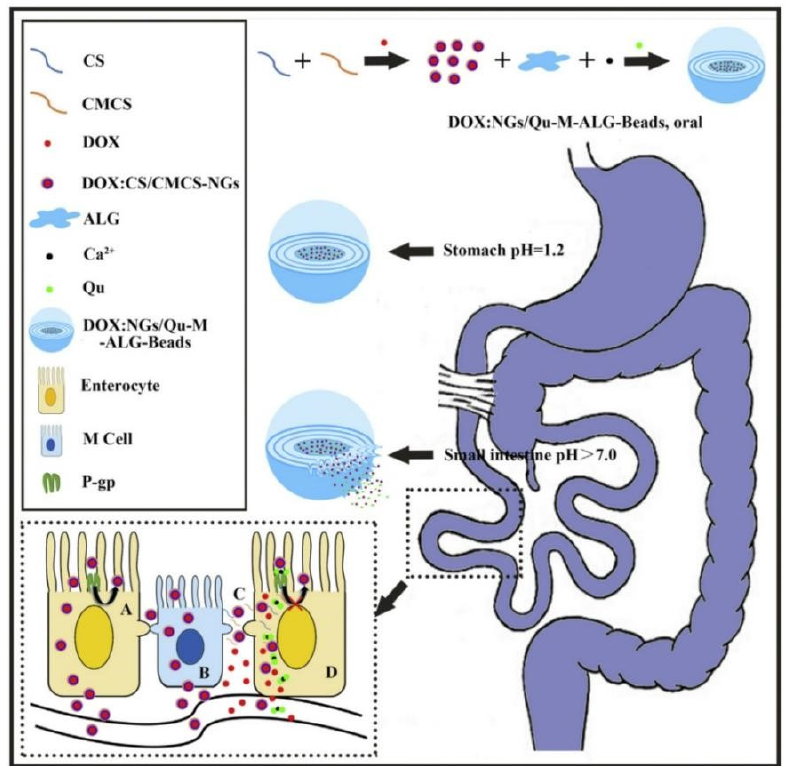
Figure 5. Schematic illustrating the effect of DOX: NGs/Qu-M-ALG-Beads on improving the oral absorption of DOX: (A) transcellular pathway by pinocytosis, (B) transcytosis by M cell, (C) para- absorption of DOX: A: transcellular pathway by pinocytosis, B: transcytosis by M cell, C: paracellular cellular pathway by CS/CMCS-NGs induced tight junction opening and (D) inhibition of P-gp in pathway by CS/CMCS-NGs induced tight junction opening and D: inhibition of P-gp in enterocyte enterocyte by Qu. Reprinted with permission from [97]. Copyright© 2016 Elsevier B.V. by Qu. Reprinted with permission from [97]. Copyright© 2016 Elsevier